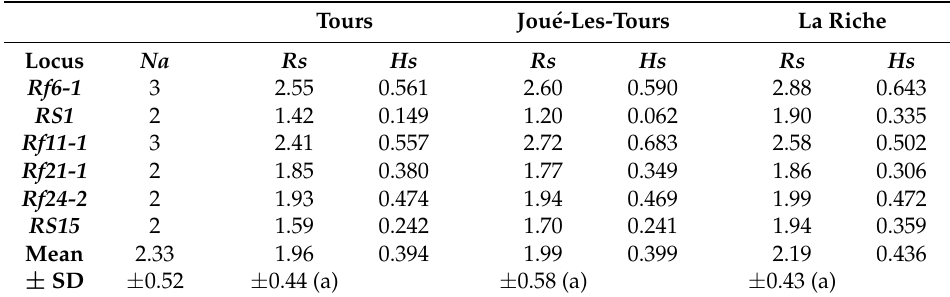
Table 3. Variability at six microsatellite loci for Reticulitermes flavipes termites taken from colonies in and around Tours, France. The number of alleles per locus ( Na ), allelic richness ( Rs ), and gene diversity ( Hs ) were calculated using all the